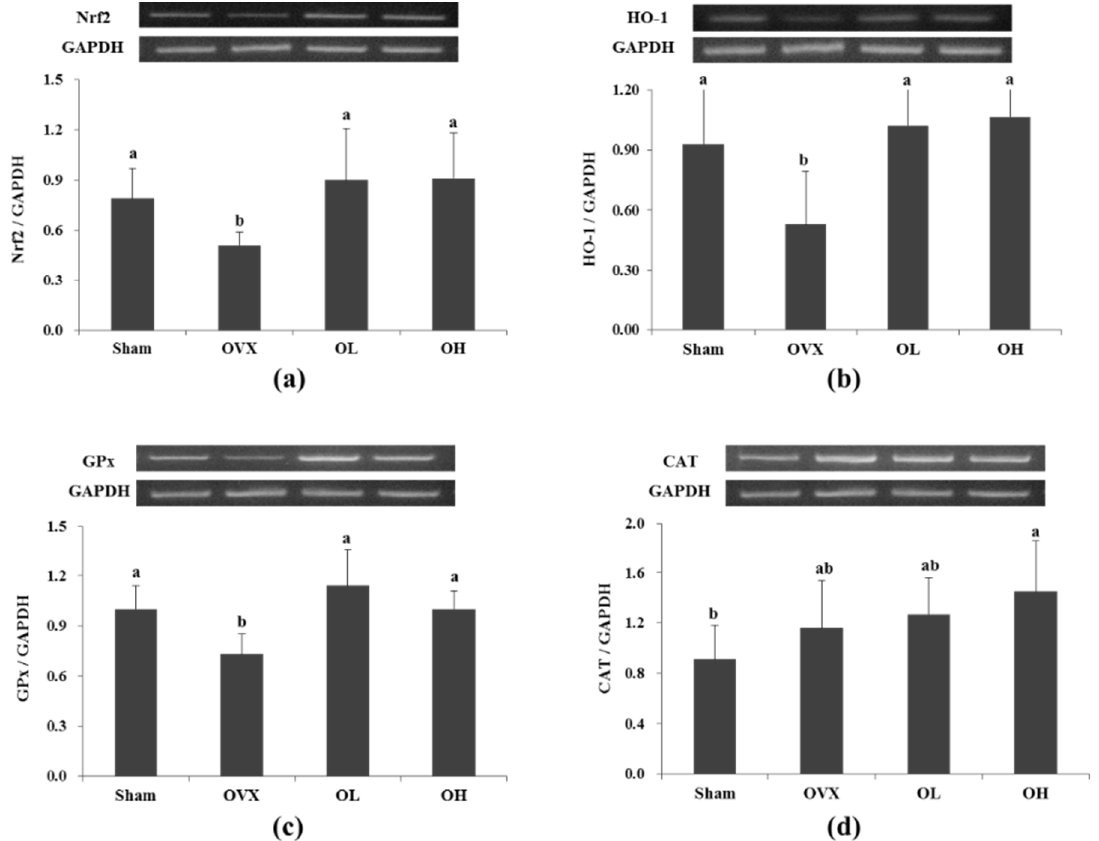
Figure 6. mRNA expression of Nrf2, HO ‐ 1, GPx and CAT in liver of each group. ( a ) Nrf2; ( b ) HO ‐ 1; ( c ) GPx; ( d ) CAT. Values are mean ± SD ( n = 7 for each group). The different letters (a > b > c) within a column indicate significant differences ( p < 0.05) determined by Duncan’s multiple range test; Sham, the non ‐ OVX control; OVX, the OVX ‐ control; OL, the OVX + 100 mg/kg b.w. of hawthorn extract; OH, the OVX + 200 mg/kg b.w. of hawthorn extract; Nrf2, Nuclear factor erythroid 2–related factor; HO ‐ 1, Heme oxygenase ‐ 1; GPx, Glutathione peroxidase; CAT, Catalase; GAPDH, Glyceraldehyde ‐ 3 ‐